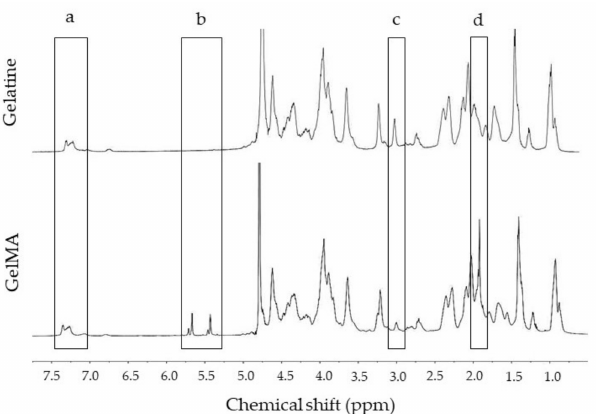
Figure 1. Representative NMR spectra of unmodified gelatine and GelMA. ( a ) Phenylalanine’s aromatic rings were used for normalisation around 7.35 ppm (5 protons). ( b ) Methacryloyl groups in GelMA seen as a double peak between 5.3–6.8 ppm absent in gelatine. ( c ) Lysine and hydroxylysine peaks before and after methacrylation at 2.90 ppm. ( d ) Corresponds to NH 2 group substitutions by methyl protons of methacryloyl groups absent in unmodified gelatine at 1.8 ppm.